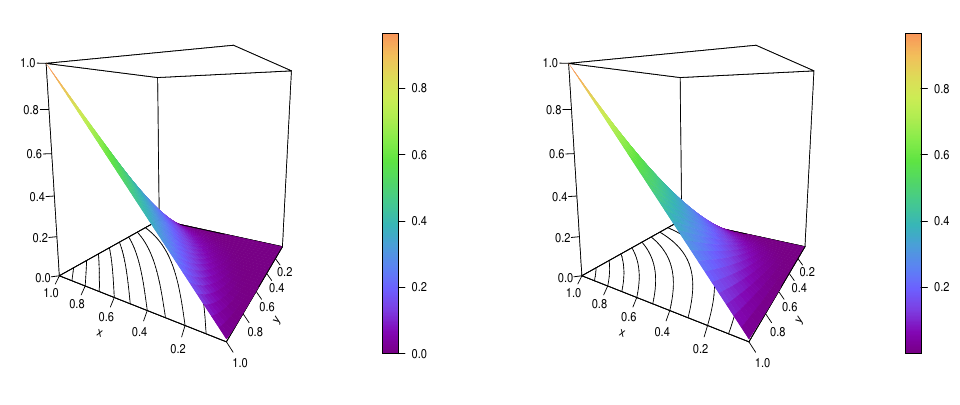
Figure 2. Plots of the IP copula for α = 1/2 and β = 2 ( left ) and β = 1/2 ( right ).